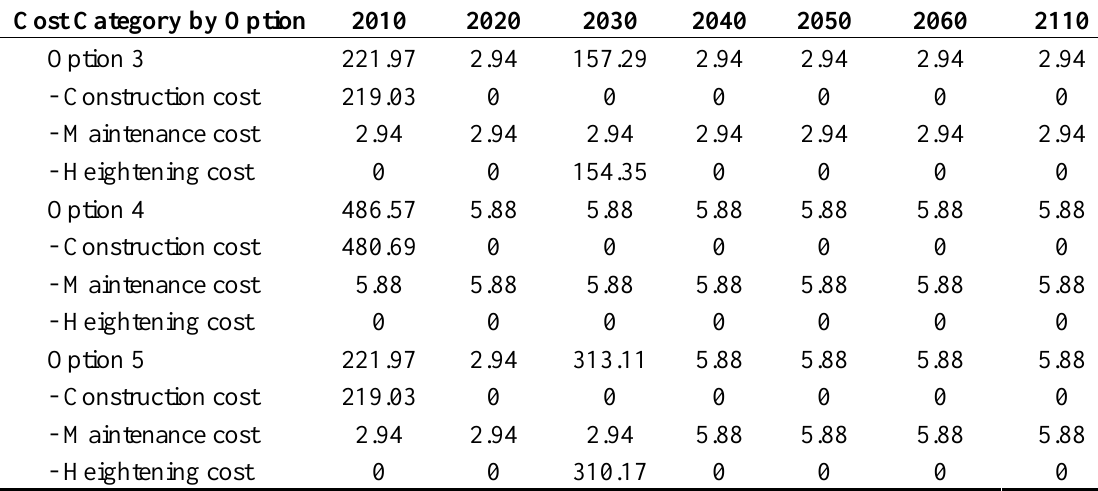
Note: Maintenance cost is yearly annuity cash flow. Table A10. Benefits of dike options (unit: million